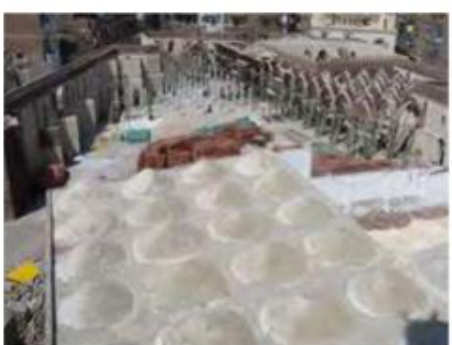
Figure 7. Mosque Zaghlul (1577)